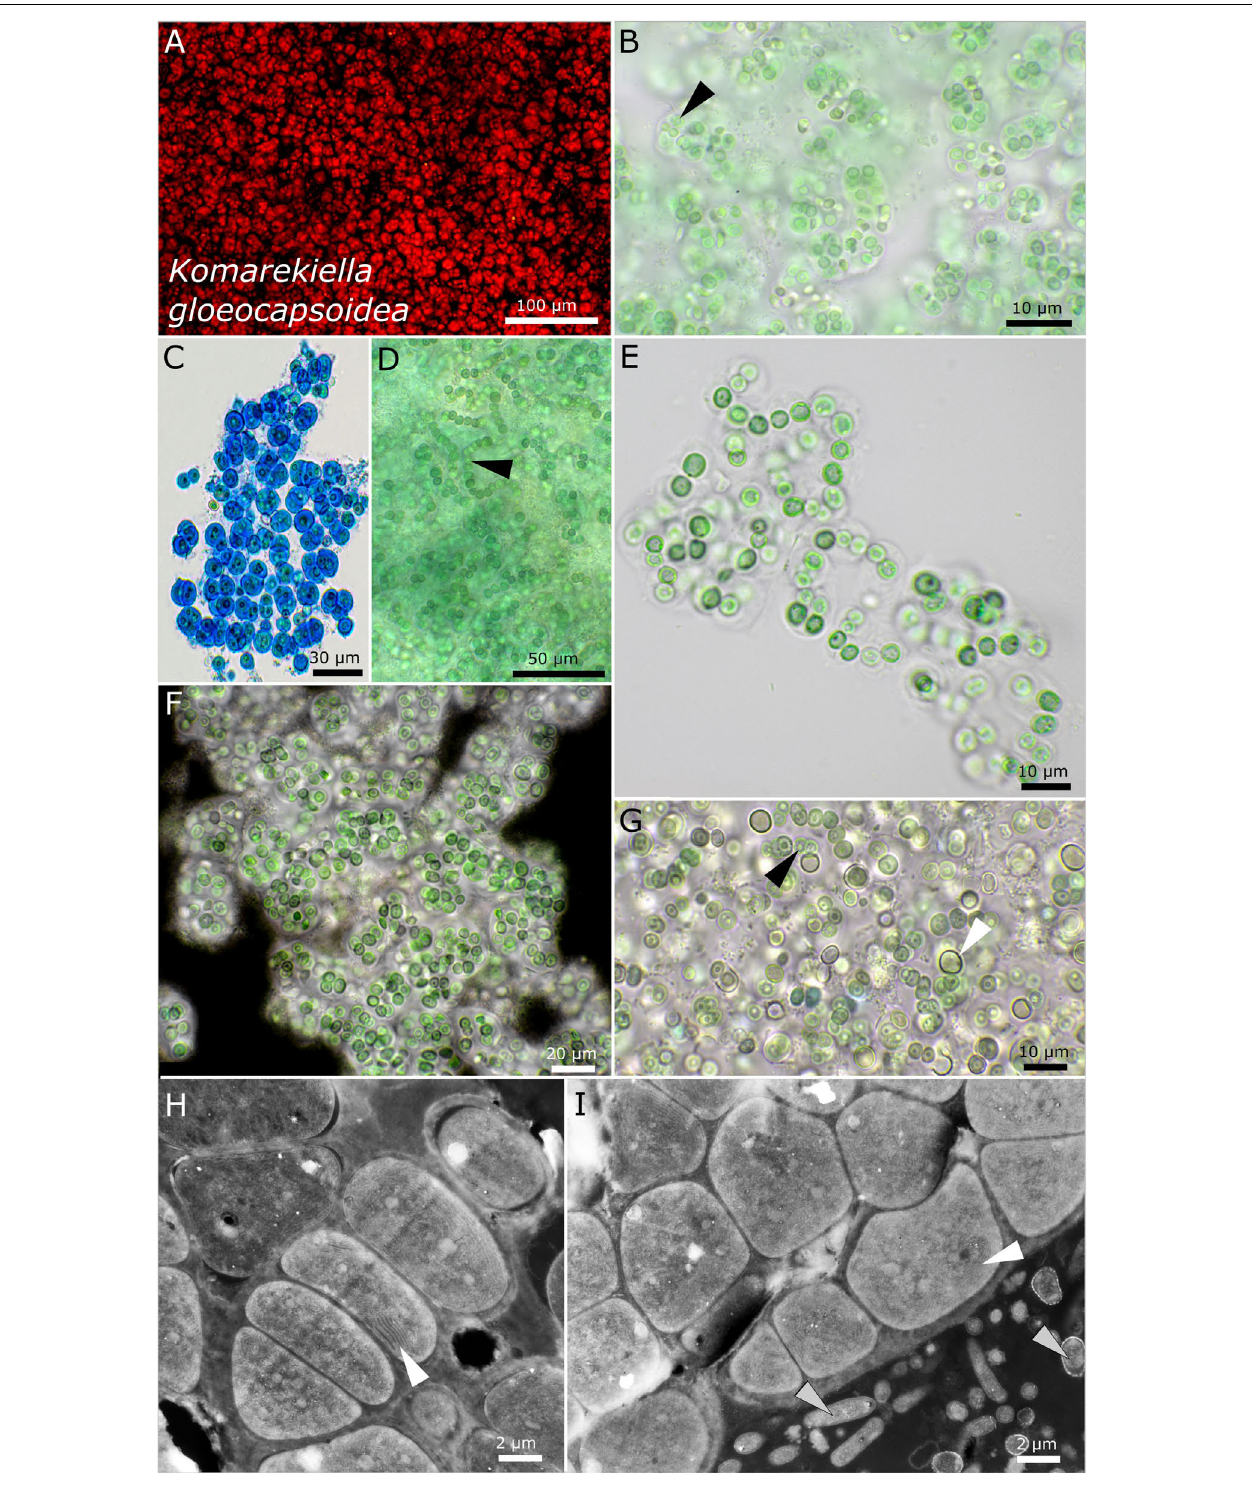
FIGURE 8 | Micrographs of Komarekiella gloeocapsoidea . (A) Autofluorescence, (B–G) light microscopy, and (H,I) transmission electron microscopy (TEM) of lichen cross-sections. (A) Overview showing the Gloeocapsa -like single cell habitus of the species. (B) Praemordium-like stadium of the colony with wide but limited sheaths and the vacuole-like structure in the center of the cells (white arrow). (C) ACN stain dyeing the wide and limited sheaths of the cells of which always only a few are clustered together resembling Gloeocapsa . (D) Filamentous state only observed during heavy contamination with heterotrophic bacteria. Note the